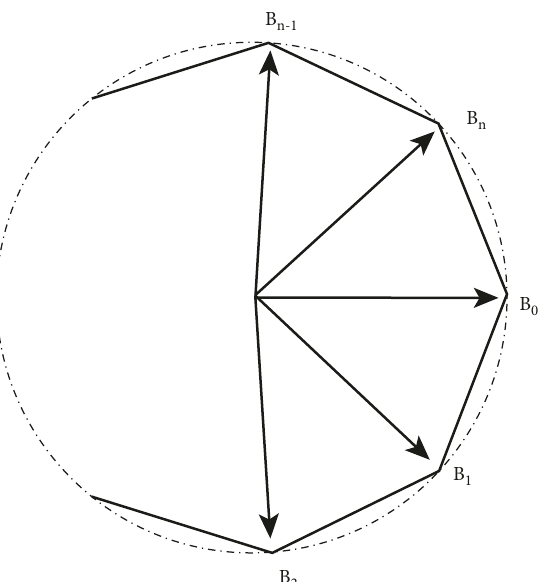
Figure 5: On n -gon representation of Pell polynomials kept clockwise at its